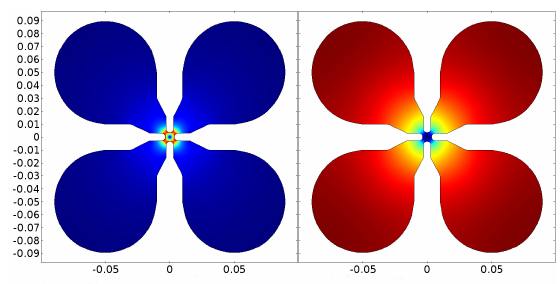
Figure 10. Cross section of the RFQ, showing normalized elec- tric (left) and magnetic (right) field distribution for the quadrupo- lar